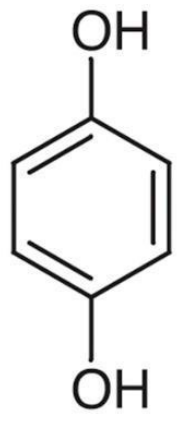
Figure 1. Hydroquinone structure.